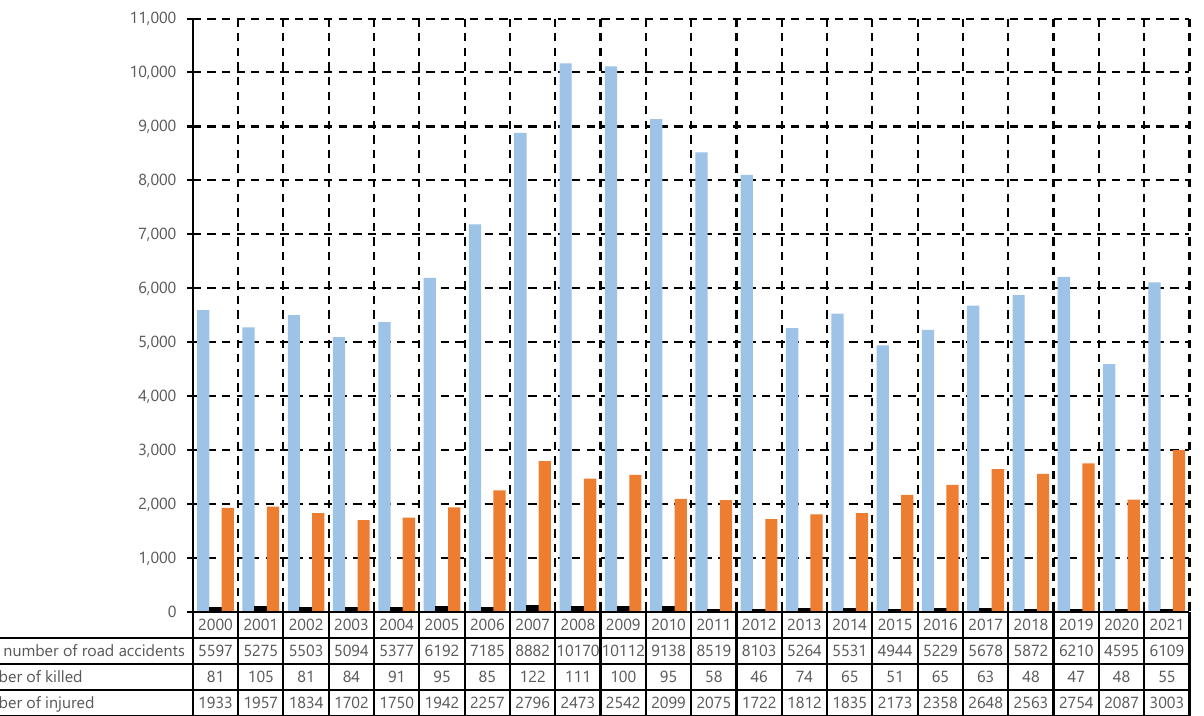
Figure 1. Annual statistics of road traffic accidents and casualties in Montenegro